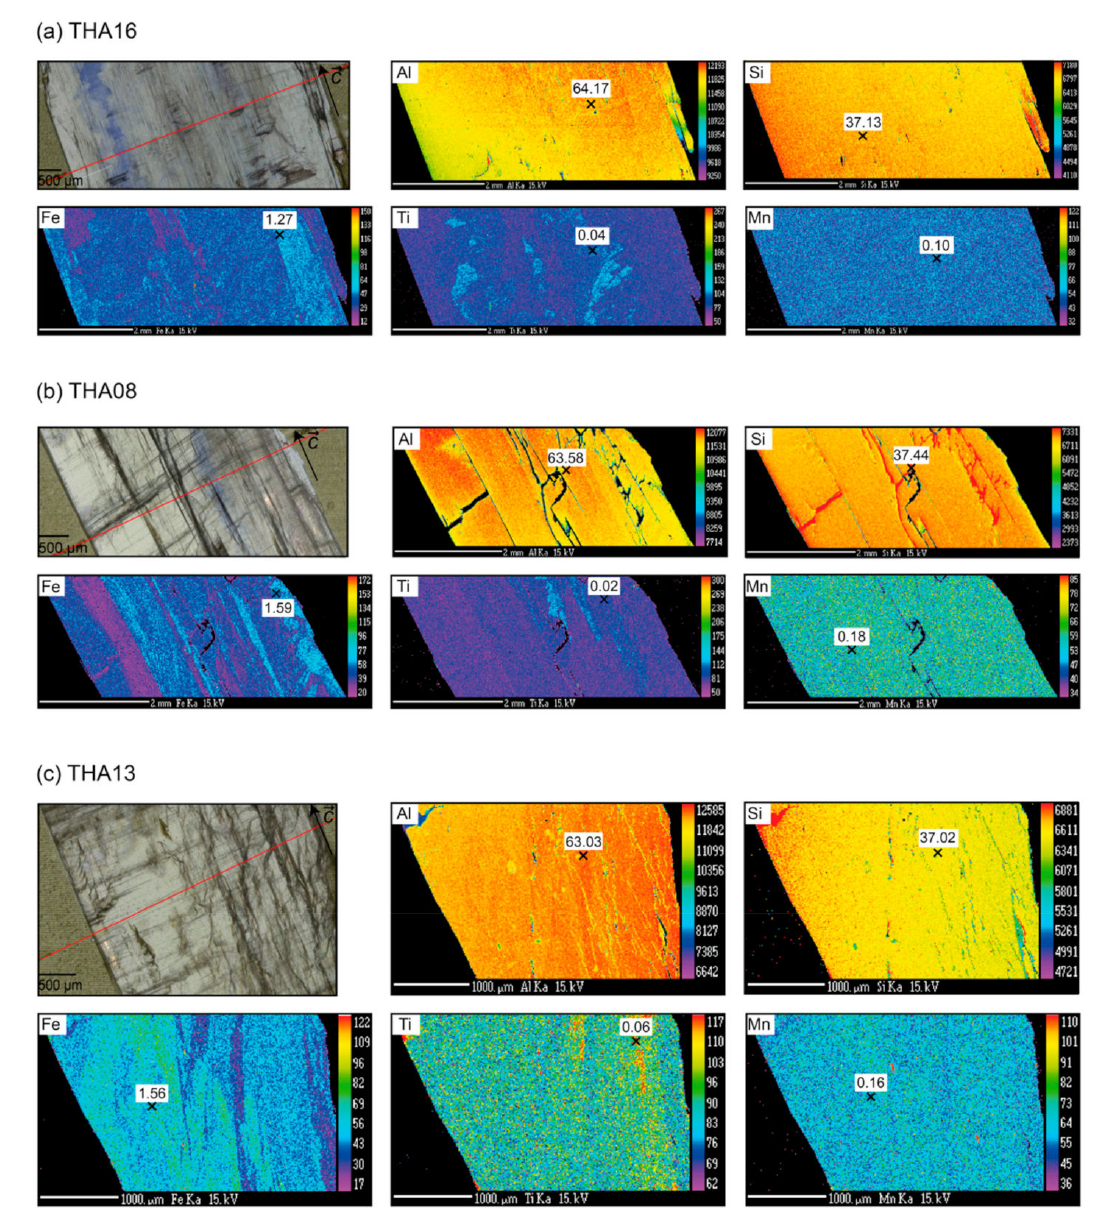
Figure 12. Electron probe microanalyses (EPMA) semi-quantitative X-ray maps of Al, Si, Fe, Ti and Mn on the < 100 > faces of blue-green THA16 ( a ), yellow THA08 ( b ) and orange THA13 ( c ) kyanite samples, with color scales expressed in counts, not calculated to concentration. The red line corresponds to the EPMA quantitative profile analyses (Table S12d–f). The maximum values (in oxide wt. %) measured along the profile for a given element is reported on each